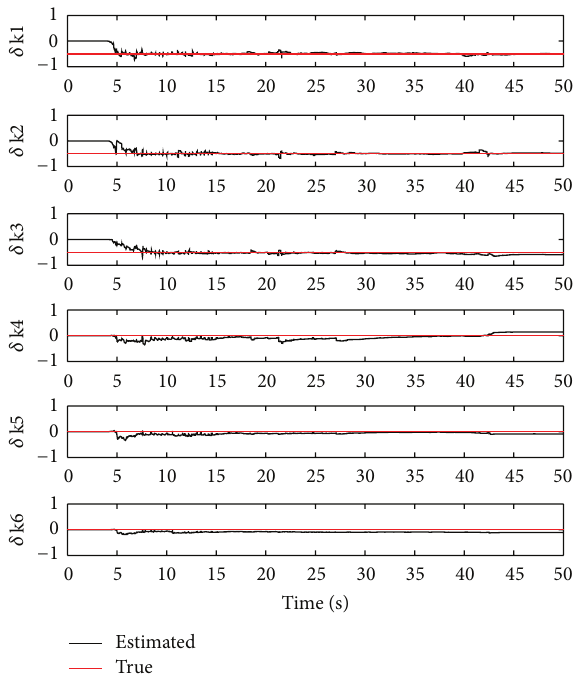
Figure 3: Damage stiffness estimation using the OTSKE with 𝑄 𝑑 𝑘 = 1000𝐼 6 .